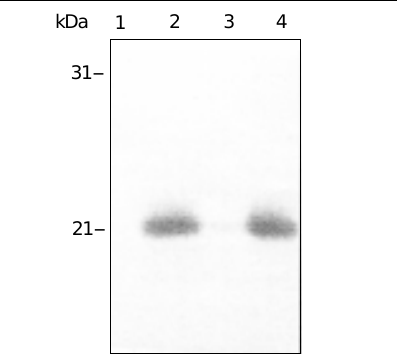
Figure 4 - Detection of MPB70 expressed in M. smegmatis. Western blot: anti-MPB70 was used as first antibody. Lanes